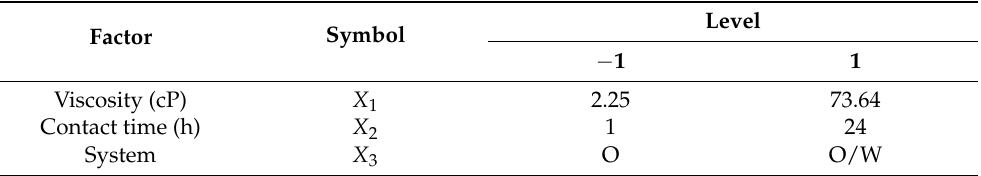
Table 1. Factors and levels used in experimental design his is a table. Level Factor Symbol − 1 1 Viscosity (cP) X 1 2.25 73.64 Contact time (h) X 2 1 24 System X 3 O